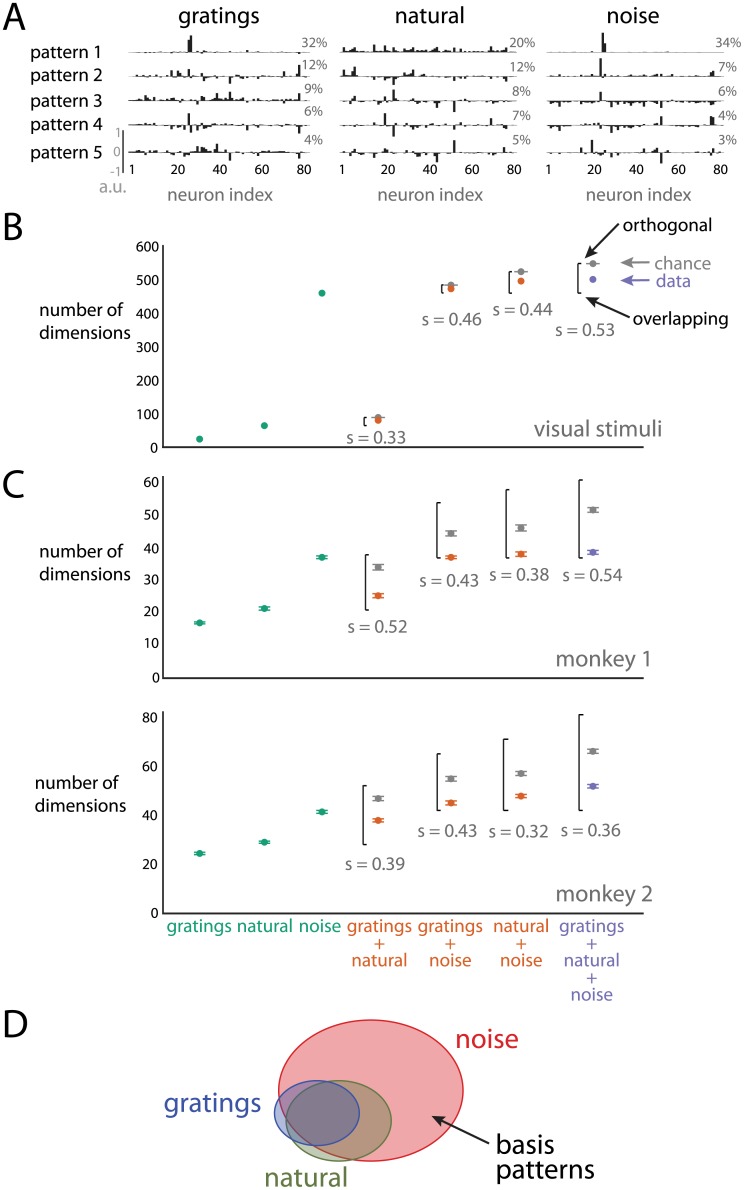
Similarity of basis patterns across stimuli.A: Basis patterns describing the largest percentage of variance for the population responses to the gratings, natural, and noise movies for monkey 2. Each pattern is a unit vector with a norm of 1. Percentages denote percent variance explained by each pattern. B: Dimensionality of visual stimuli for individual movies (teal dots), and combinations of two (orange dots) or three (purple dots) movies. The teal dots correspond to where the curves intersect the dashed lines in Fig 3B. Black brackets denote the range of possible dimensionalities (bottom of the black bracket corresponds to overlapping patterns; top of the black bracket corresponds to orthogonal patterns). Gray dots indicate dimensionalities expected by chance, and error bars represent the standard deviation of 100 random samples. The similarity index s indicates if patterns overlap more than expected by chance (s > 0) or are closer to orthogonal than expected by chance (s < 0). C: Dimensionality of population activity, for individual and combinations of movies. Same conventions as in B. Error bars represent standard deviations of the subsampled estimates. D: Venn diagram that summarizes the similarity of basis patterns across stimuli. The size of each ellipse indicates the number of basis patterns, and the overlap indicates the extent to which basis patterns are shared by different stimuli.